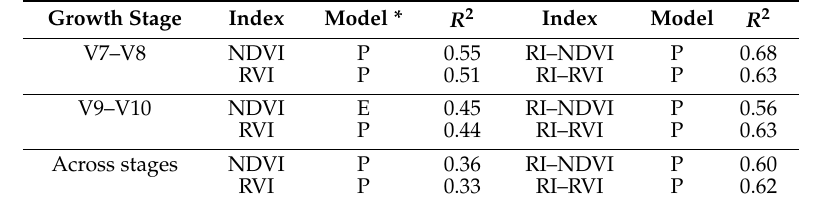
Table 5. Coefficients of determination ( R 2 ) for the relationships between spring maize N nutrition index (NNI) and GreenSeeker sensor-based indices (normalized difference vegetation index (NDVI) and ratio vegetation index (RVI)) and response indices (RI–NDVI and RI–RVI) at different growth stages across 2014 and 2015.